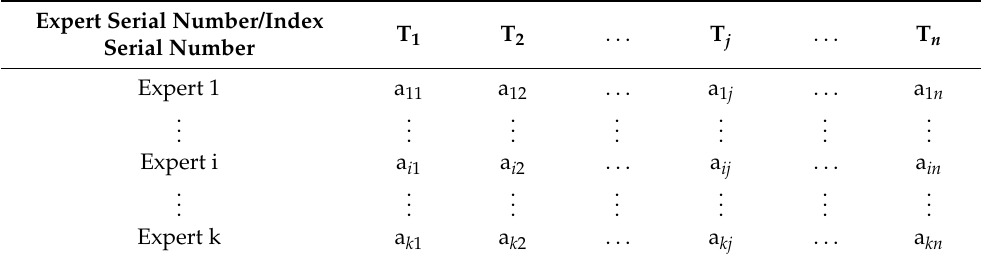
Table 8. Expert ranking list of index importance. Expert Serial